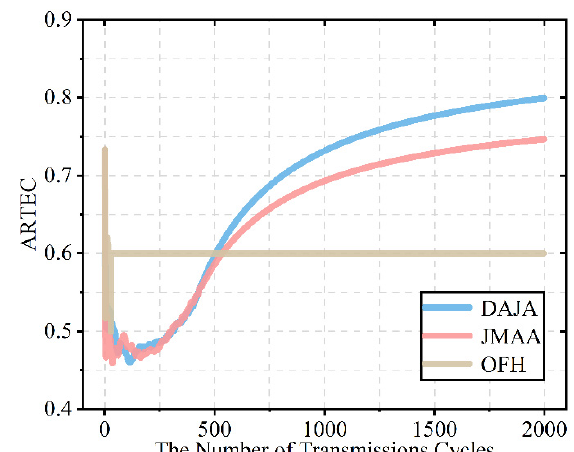
Figure 11. The schematic diagram of transmission performance comparison among DAJA, JMAA [12], and OFH.